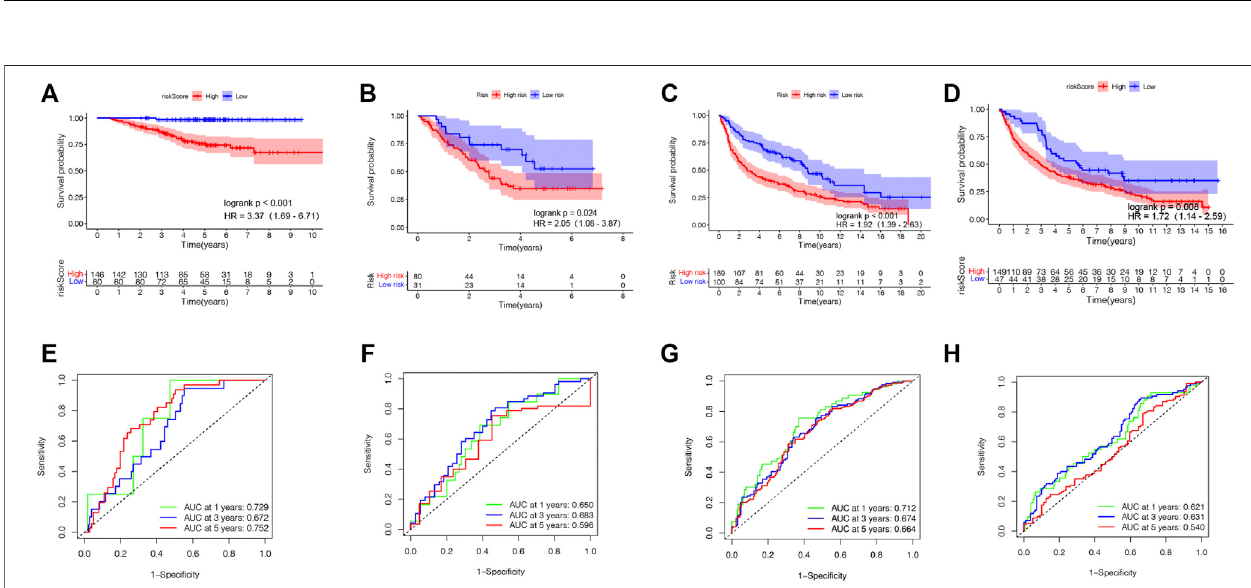
FIGURE6| Validation ofthe prognostic TRIGscoreinvariousGEO cohortsofLUAD. (A-D). Kaplan – Meier survivalcurves ofOSinfour GEO cohorts. (E-H). Time- dependent ROC curves for four GEO cohorts. (A,E) . GSE31210 ( n = 226). (B,F) . GSE3141 ( n = 111). (C,G). GSE30219 ( n = 289). (D,H) . GSE37745 ( n = 196).